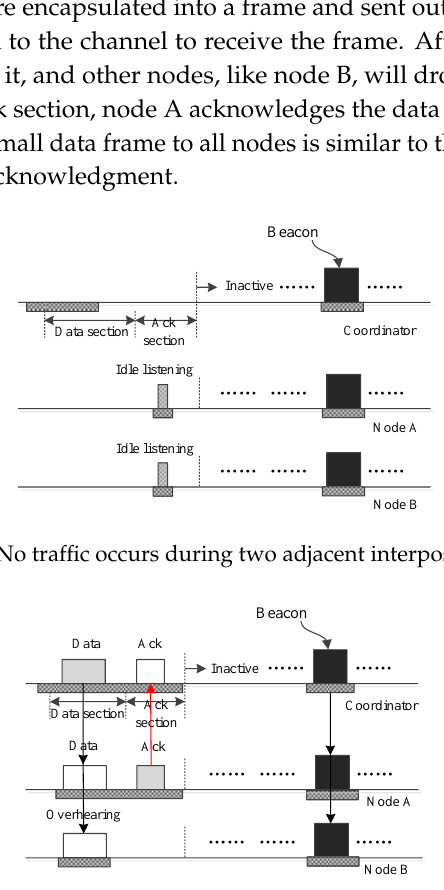
Figure 3. The coordinator sends small data to one node, A.